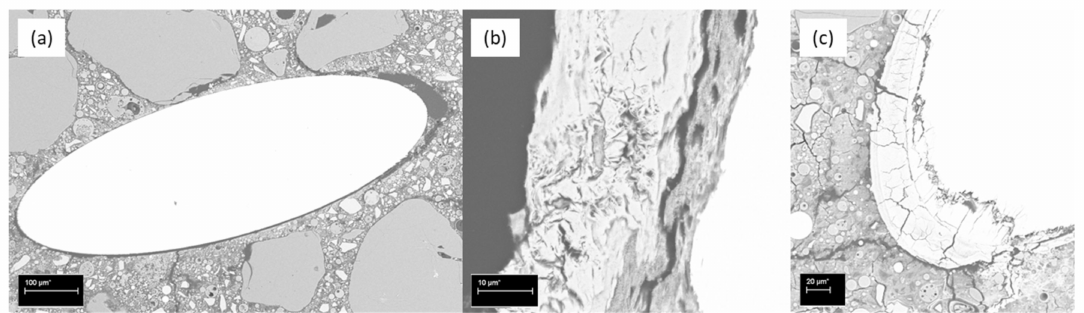
Figure 12. The steel fibres in polished thin films: ( a ) the interfacial zone between fibre and matrix, ( b ) the rust formed on the fibre, and ( c ) a fracture occurred in the